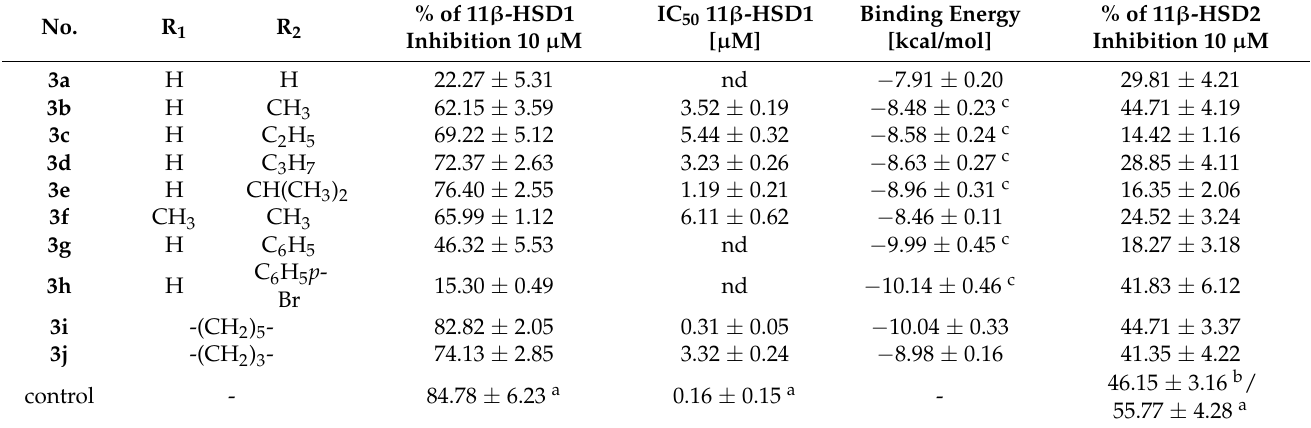
Table 2. Inhibitory activity of 2-(adamantan-1-ylamino)thiazol-4(5 H )-one derivatives. The comparison of the experimental data and the binding energies collected in the docking study. The calculation results were averaged over 8 protein structures (11 β -HSD1) available in the PDB database; the corresponding standard deviations are given.